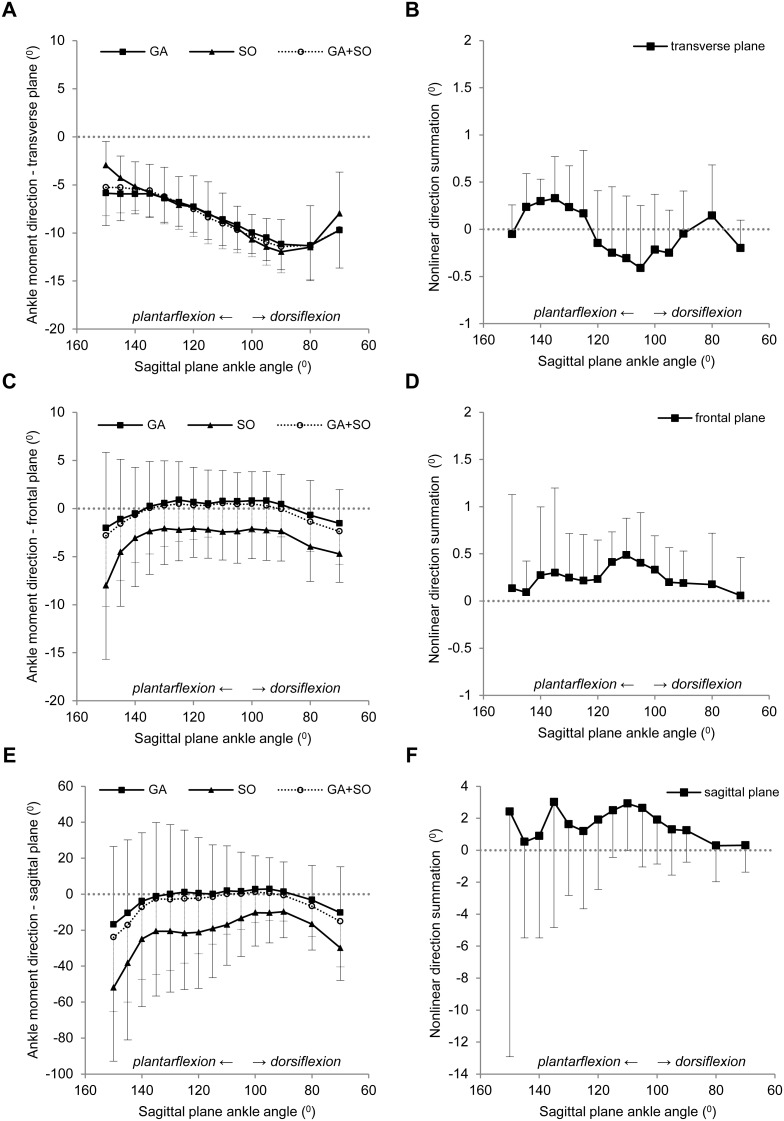
Effect of ankle dorsi-flexion on the nonlinear direction summation in the transverse, frontal and sagittal planes.Active moment direction in the transverse (A), frontal (C) and sagittal (E) planes exerted by simultaneous excitation of GA+SO (○), and by individual excitation of SO (▪) and GA (▴) plotted as a function of sagittal plane ankle angle. Knee angle was kept constant at 90°. Negative values indicate an eversion vector in the transverse plane and an internal rotation vector in the frontal and sagittal planes. Significant effects of ankle angle on the SO (p<0.001) and GA (p<0.001) vector in the transverse plane and on the SO vector (p = 0.021) in the sagittal plane were found. SO vector in the frontal plane (p = 0.059) and GA vectors in the frontal (p = 0.217) and sagittal (p = 0.245) planes were, however, not affected by ankle angle. The effect of sagittal plane ankle angle on the direction summation in the transverse, frontal and sagittal planes are presented in panel B, D and F, respectively. Ankle angle did not significantly affect the nonlinear direction summation in the transverse (p = 0.078), frontal (p = 0.684) and sagittal (p = 0.820) planes. The absolute amplitude of nonlinear direction summation was, however, on average significantly different from zero in all planes (p<0.001). Means ± s.d. are shown (n = 10).